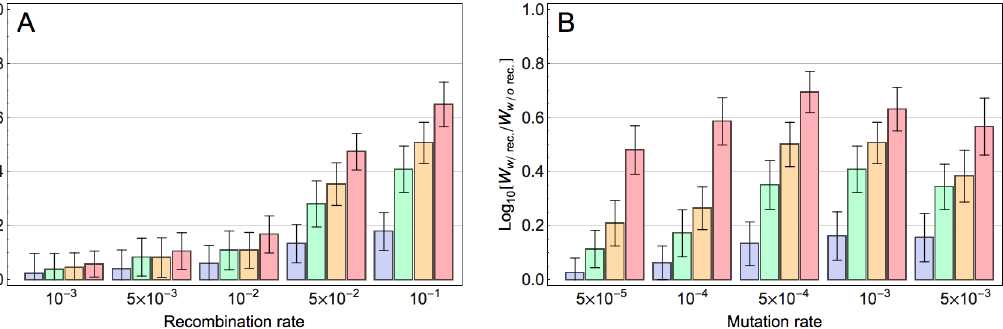
Figure 2. Effect of model parameters on the impact of recombination on adaptation. Each bar corresponds to the relative fitness of the recombining to the non-recombining population at generation 100, measured by taking the logarithm (base 10) of the ratio of mean fitness of the recombining population to that of the non-recombining population and averaged across 100 simulations. The blue, green, orange and red bars correspond to population sizes 10 4 , 5 | 10 4 , 10 5 and 5 | 10 5 , respectively. The error bars show the standard deviation of the difference between two q ffiffiffiffiffiffiffiffiffiffiffiffiffiffiffiffiffiffiffiffiffiffiffiffiffiffiffiffiffiffiffiffiffiffiffiffiffiffiffiffiffiffiffiffiffi z s 2 ). A) The effect of recombination rate at different population sizes for mutation rate: u ~ 10 { 3 . B) log normal distributions ( s 2 log( W w = rec ) log( W w = orec ) The effect of mutation rate at different population sizes for recombination rate: r ~ 10 { 1 . (The effect of recombination is still significant for populations larger than 10 3 with this recombination rate; see Figure